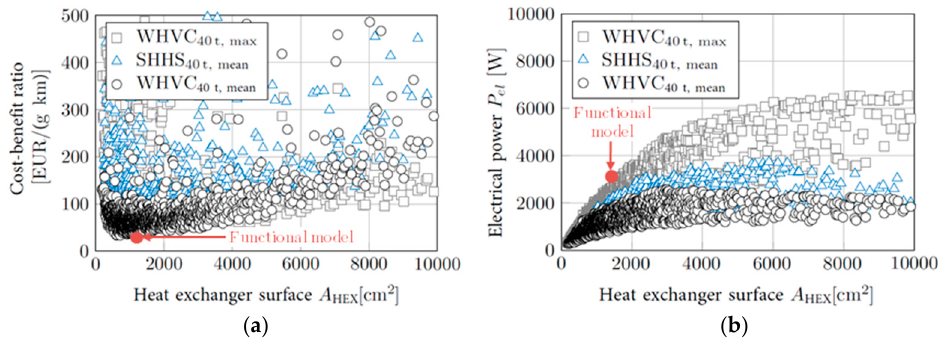
Figure 10. Overview of the multi-objective optimization of the TEG result designs with free geometric